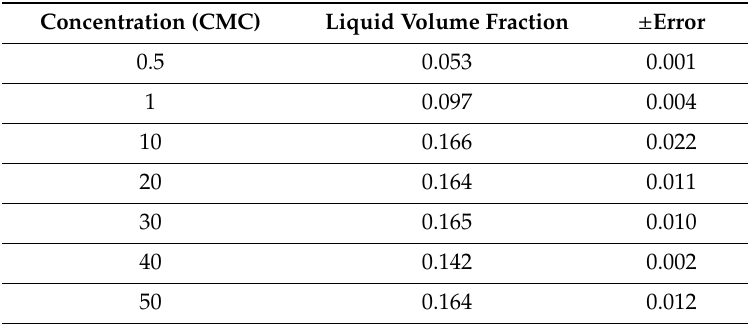
Table 7. Calculated liquid volume fraction for the foam generated for each of the concentrations of SDS